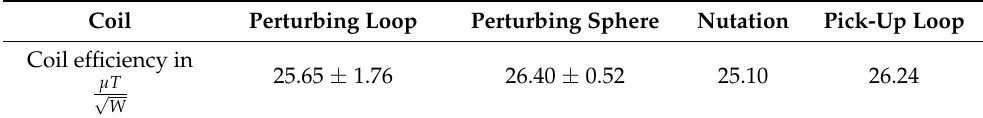
Table 1. Experimentally measured coil efficiency [37]. Coil Perturbing Loop Perturbing Sphere Nutation Pick-Up Loop Coil efficiency in µ T